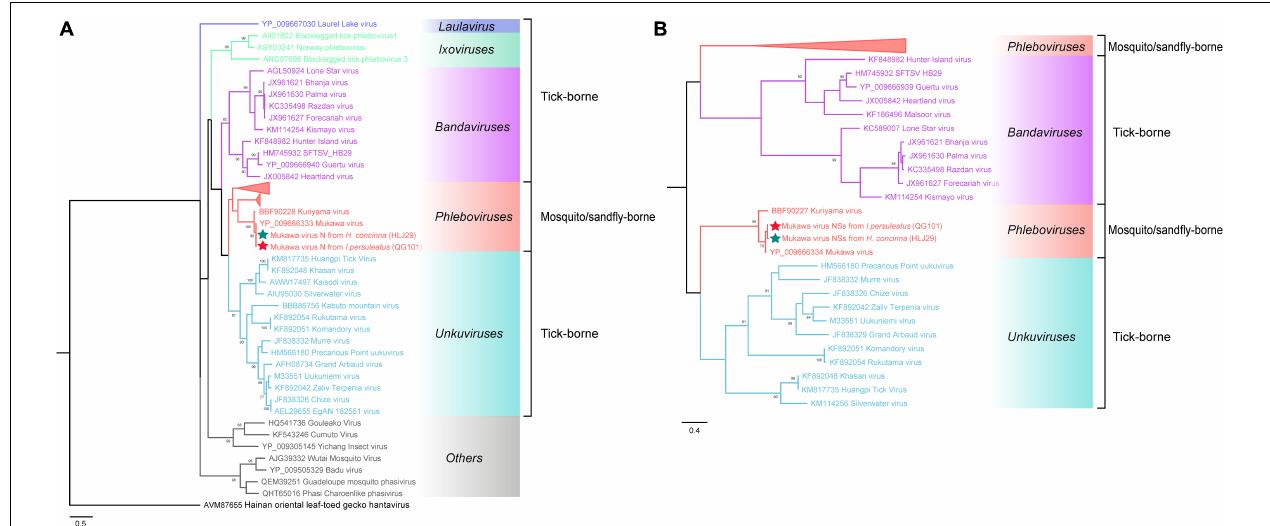
FIGURE 4 | Phylogenetic analysis of MKWV N and NSs proteins. (A) The maximum likelihood phylogenetic tree based on the deduced amino acid sequences of the MKWV nucleoprotein protein (N). (B) The maximum likelihood phylogenetic tree based on the deduced amino acid sequences of the MKWV non-structural protein (NSs). Our MKWV from I. persulcatus was labeled with a red solid five-pointed star, and our MKWV from H. concinna was labeled with a green solid five-pointed star. Trees that were generated using MEGA-X and analyzed included 1,000 bootstrap replicates.